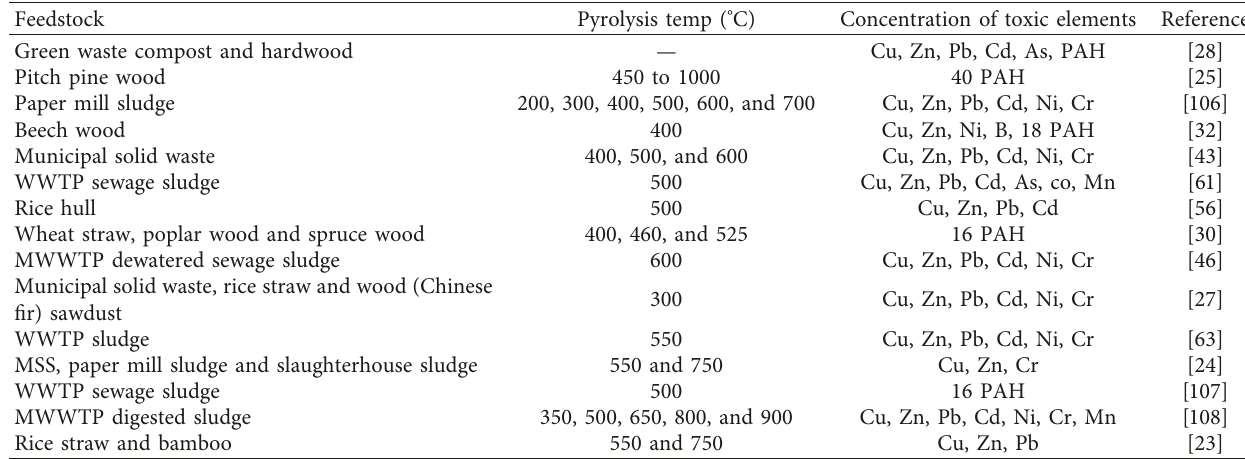
Table 3: Identified concentration of toxic organic and inorganic compounds in